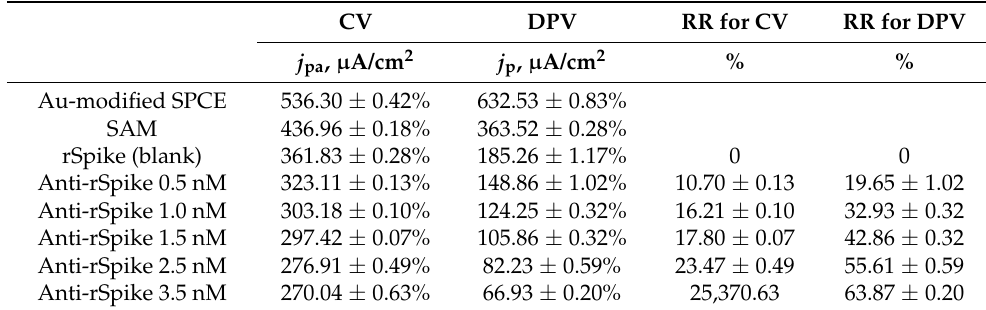
Table 2. Analytical parameters obtained from CV and DPV. Error bars are calculated as a percentage standard